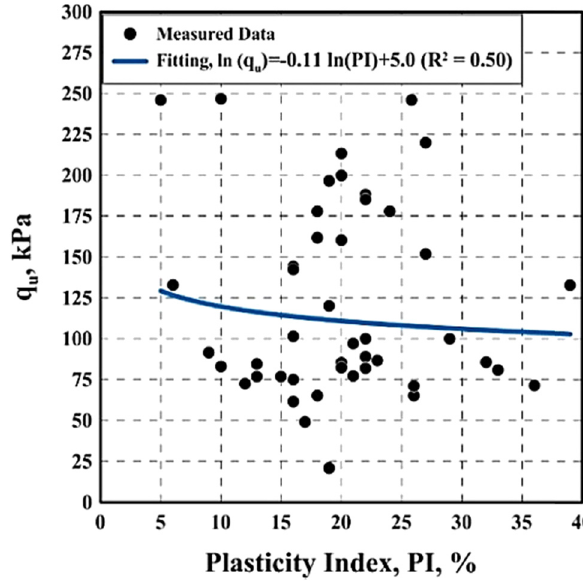
Figure 14: Uncon fi ned compressive strength versus SPT relationship.